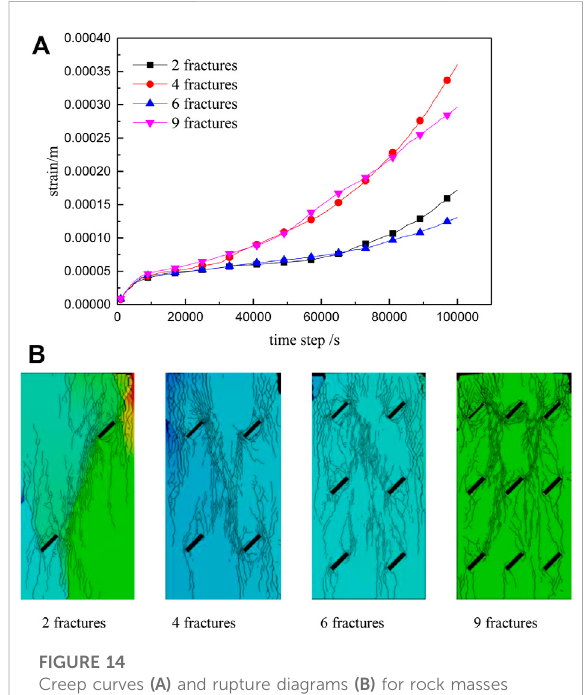
FIGURE 14 Creep curves (A) and rupture diagrams (B) for rock masses with parallel fracture